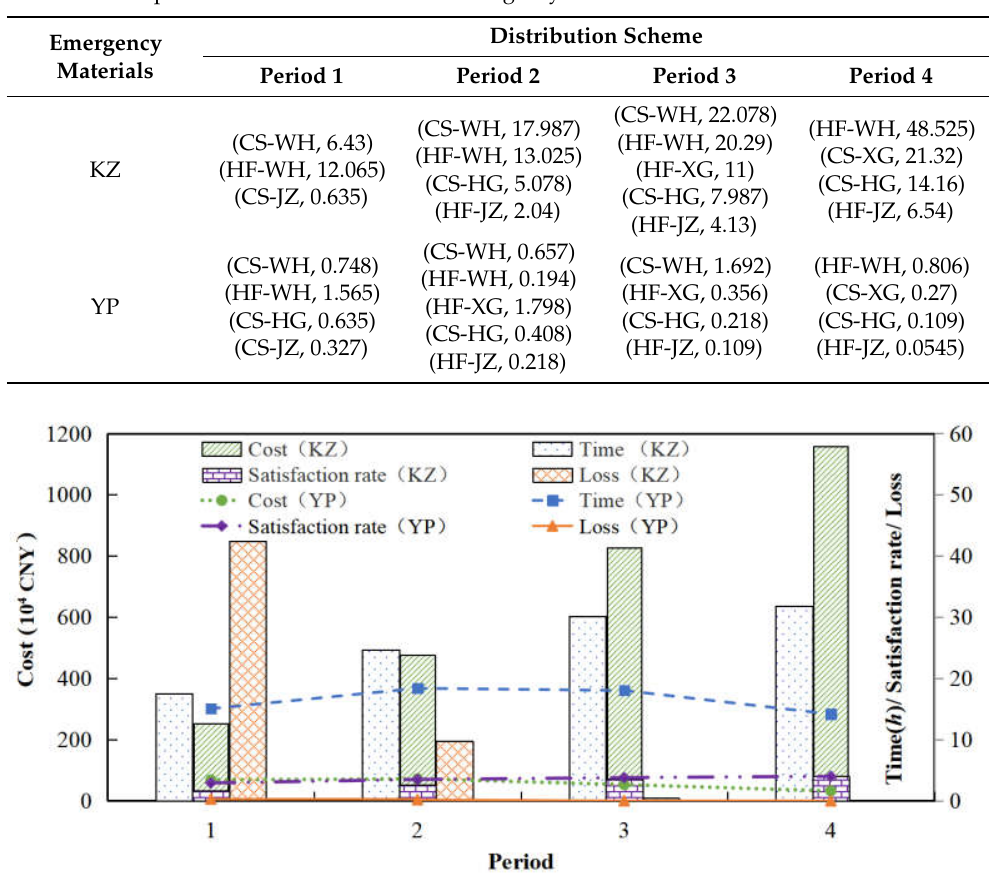
Figure 6. The multi-objective evolution trend of multi-period distribution of emergency materials based on the balance-criterion.